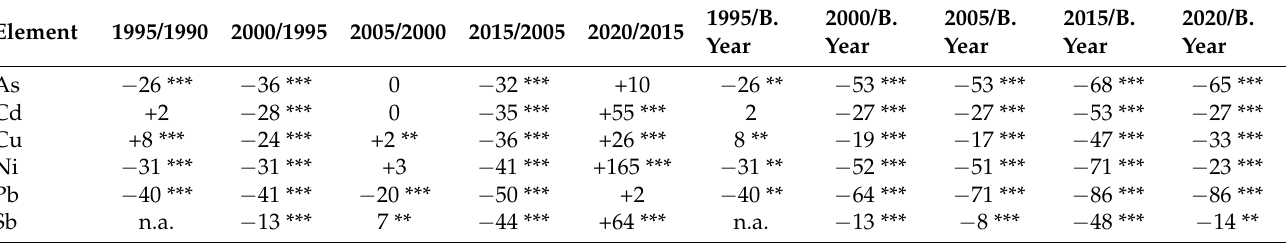
Table 5. Changes in median metal concentrations compared to the respective previous moss survey(s) (in %).